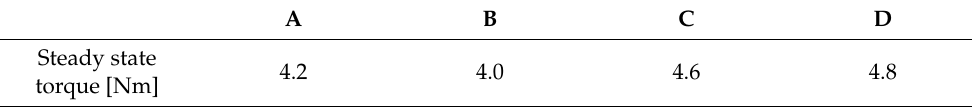
Table 3. Steady state